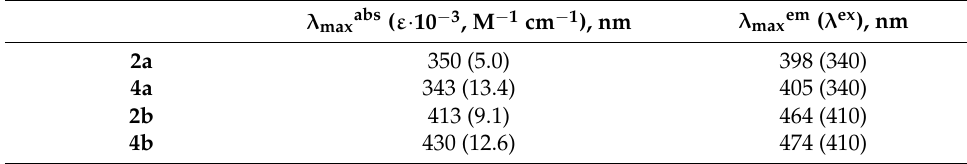
Figure 5. UV–vis (dashed line) and normalized emission (solid line) spectra of coumarin 2b in CH 3 CN (c = 1 × 10 − 4 M, black) and conjugate 4b in water (c = 0.5 × 10 − 4 M, green). Table 1. Photophysical parameters for compounds 2a , 2b , 4a and 4b .